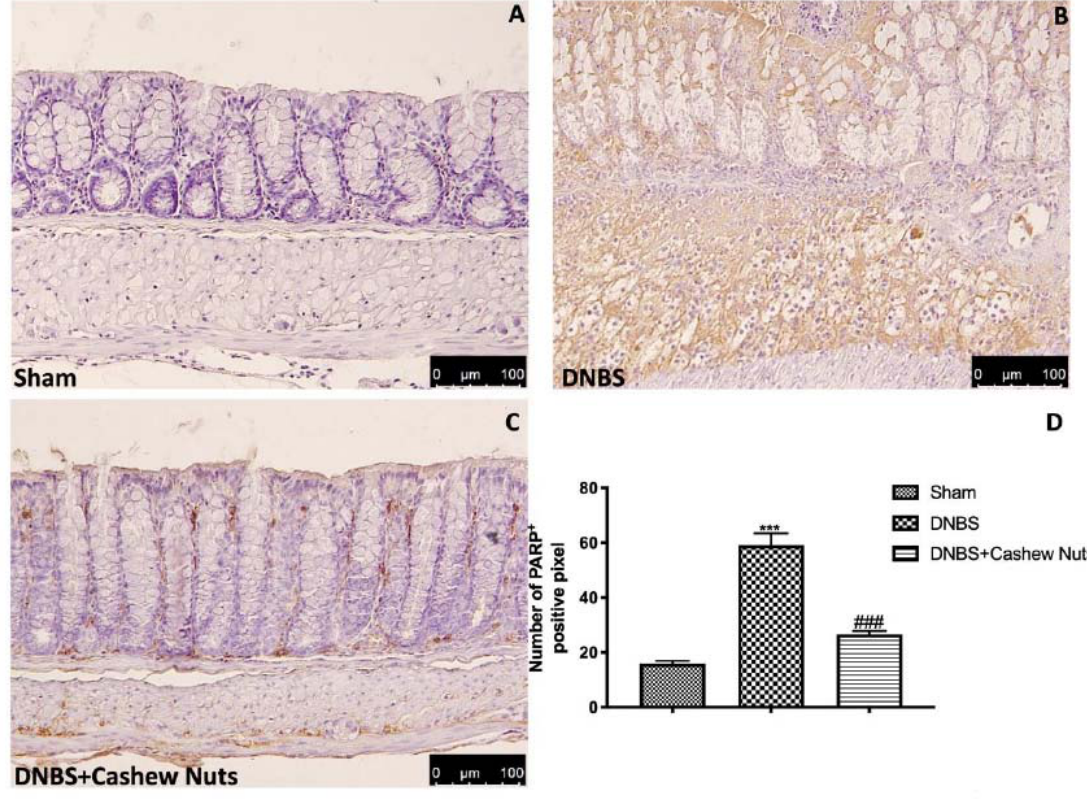
Figure 7. The e ff ects of cashew nuts on PARP expression after DNBS injection. Immunohistochemistry for PARP was evaluated in sham ( A ), DNBS ( B ), DNBS + cashew nuts ( C ). The results are expressed as % of positive pixels ( D ). Images are figurative of at least three independent experiments. Values = means ± SEM of six animals in each group; *** p < 0.001 vs. sham; ### p < 0.001 vs.